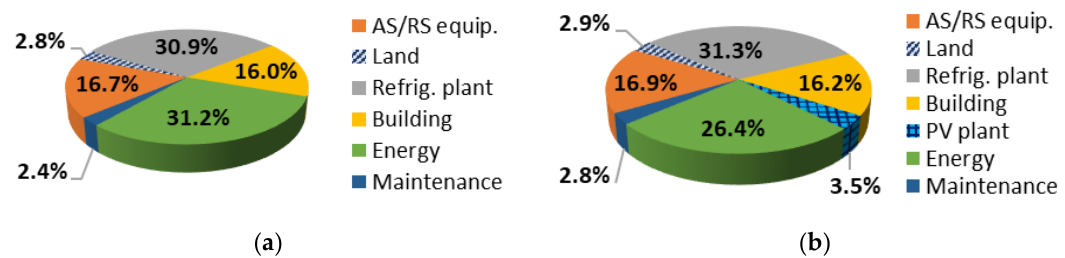
Figure 3. Optimal solution of the reference case: yearly cost structure ( a ) without and ( b ) with PV.